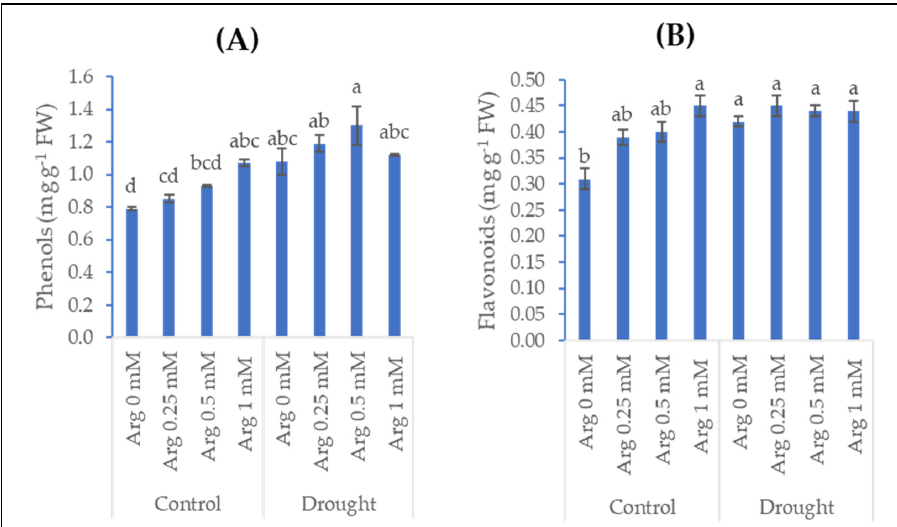
Figure 3. Effect of drought, arginine application, and their interactions on ( A ) phenols and ( B ) flavonoids content of wheat plants. Each bar represents mean ± standard error. Means that do not share the same letter are significantly different.